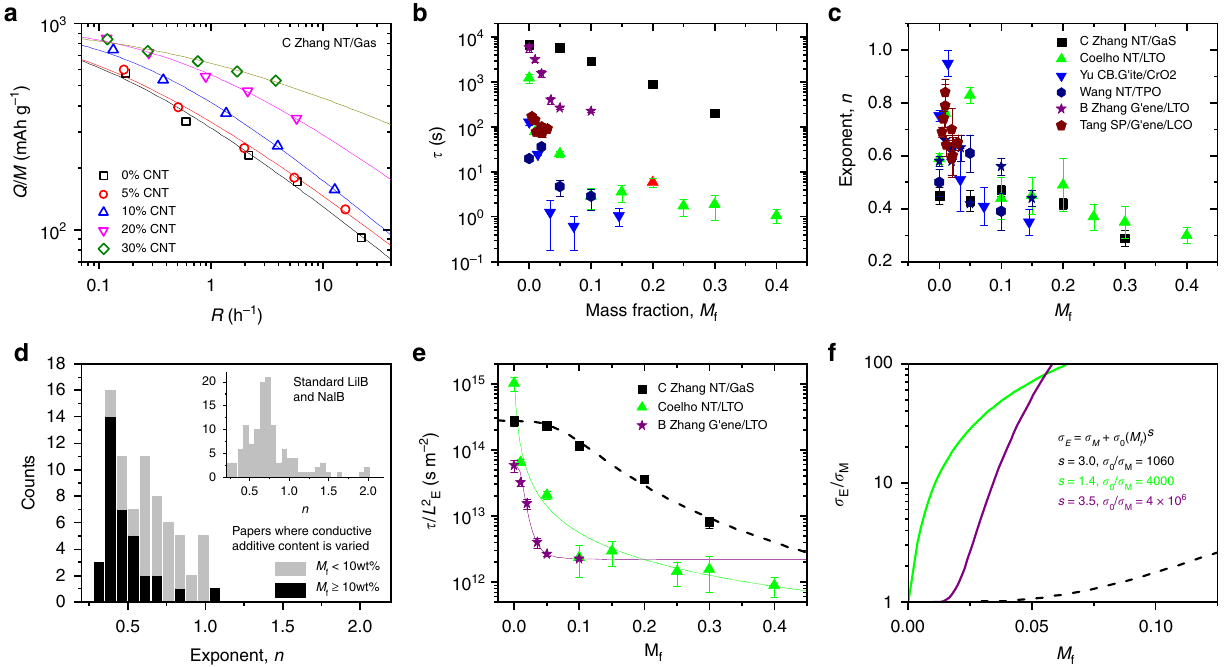
Fig. 3 The effect of varying the content of conductive additives. a Speci fi c capacity versus rate data for lithium ion anodes based on composites of GaS nanosheets and carbon nanotubes with various nanotube mass fractions 7 . The solid lines are fi ts to Eq. (2). b and c Characteristic time ( b ) and exponent ( c ), extracted from six papers (refs. 7,18,65,67 – 69 ), plotted versus the mass fraction, M f , of conductive additive. d Histogram ( N = 75) showing frequency of occurrence of n in studies which varied the conductive additive content. The histogram contains data from the papers in b , as well as additional refs. 19,70 – 73 and is divided between electrodes with high and low M f . The inset replots the data from Fig. 2f for comparison. e Data for τ = L 2 plotted versus M f for three selected papers 7,18,67 . The solid lines are fi ts to Eq. (6a) combined with percolation theory (Eq. (7). f Out of plane conductivity, σ E , of composite electrodes normalised to the conductivity of the active material alone, the relevant parameters. N.B. the legend/colour coding in c applies to b , c , e , f . All errors in this fi gure are fi tting errors combined with measurement